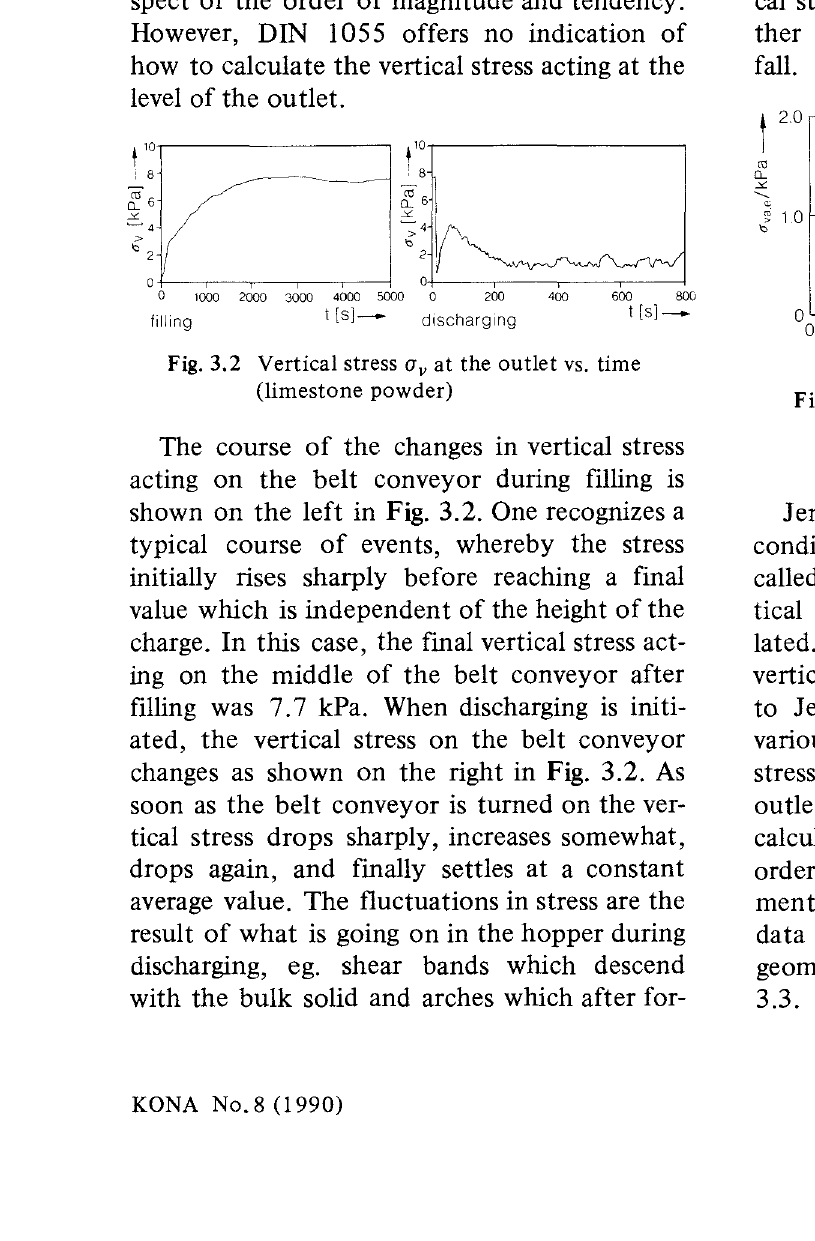
(observed values and values calculated according to J